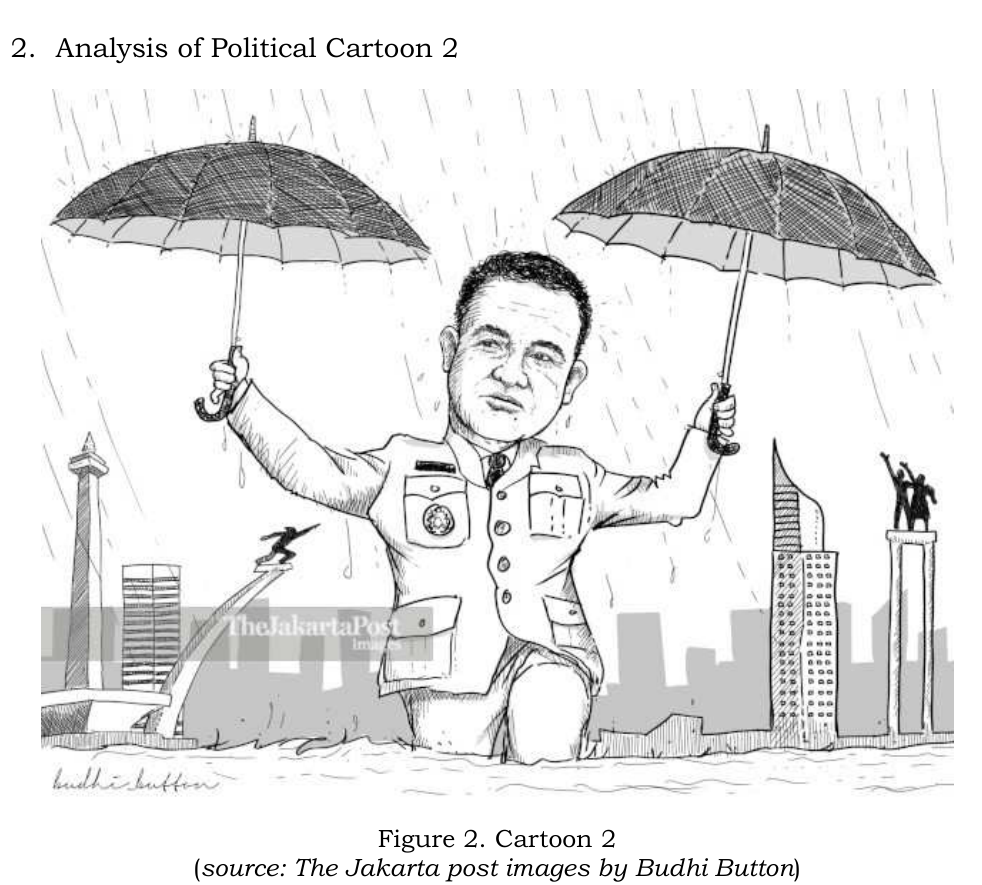
( source: The Jakarta post images by Budhi Button